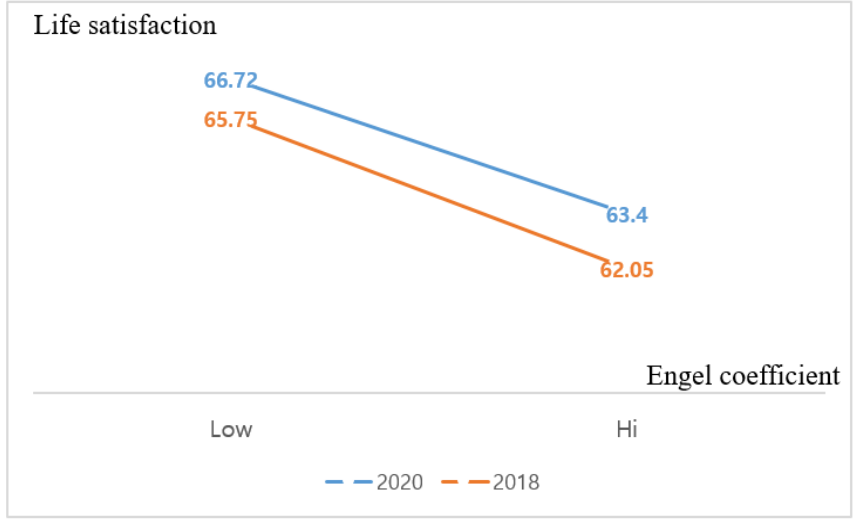
Figure 3. Moderating effect of COVID-19 between life satisfaction and Engel coefficient.